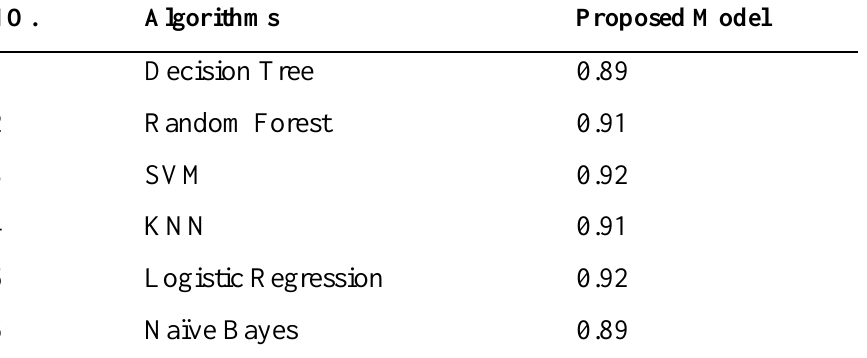
Table 2. The Classification accuracy in the proposed model